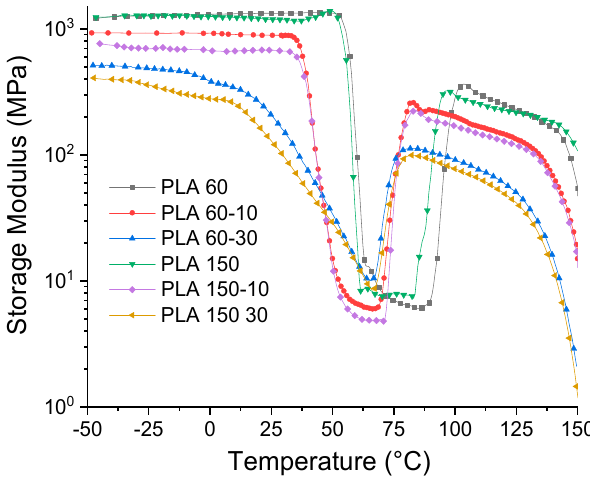
Figure 12. Storage modulus for PLA and PLA / ATBC. Table 3. Dynamic Mechanical Analysis (DMA) results of the studied materials. .8